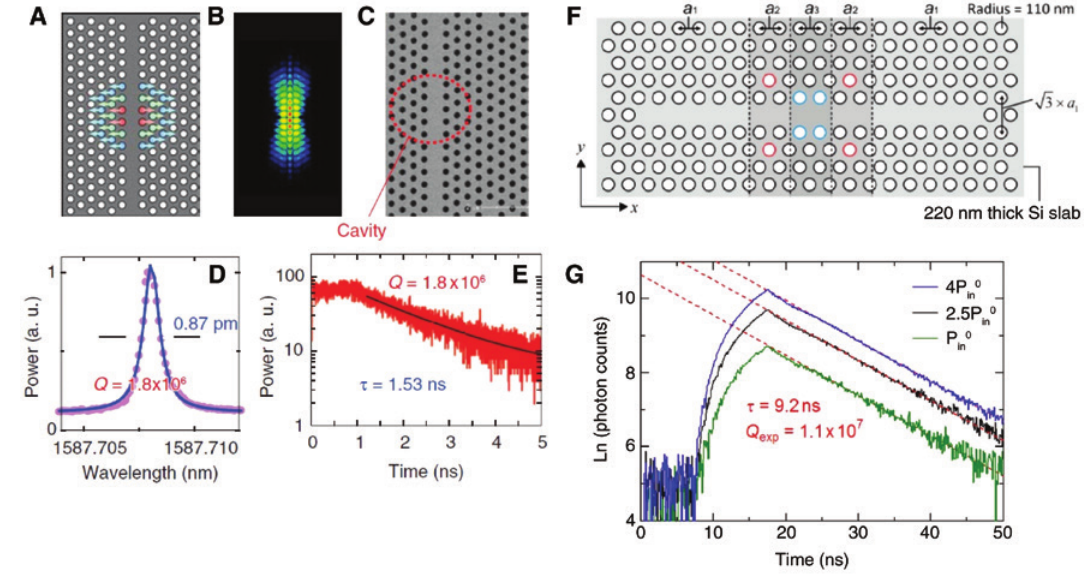
Figure 20: Photonic crystal structures designed to include high- Q nanocavities. (A) Ultrahigh- Q PhC nanocavities. (B) The associated computational design of a width-modulated line-defect cavity in a Si hexagonal air- hole PhC (i.e. calculated field intensity profile). (C) SEM image of the actual fabricated sample. (D) Experimentally recorded transmission spectrum and (E) time-resolved measurement of the output intensity decay from the cavity. Adapted from [128]. (F) and (G) Heterostructure nanocavity resulting in experimental Q -factors greater than 1.1 × 10 7 . The designed heterostructure PhC nanocavity is featured above, while the photon decay curve is below. Adapted from